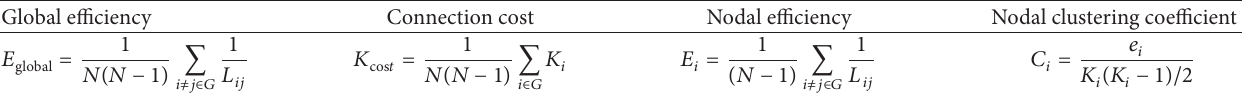
Table 1: Mathematical formulas used in graph theoretical